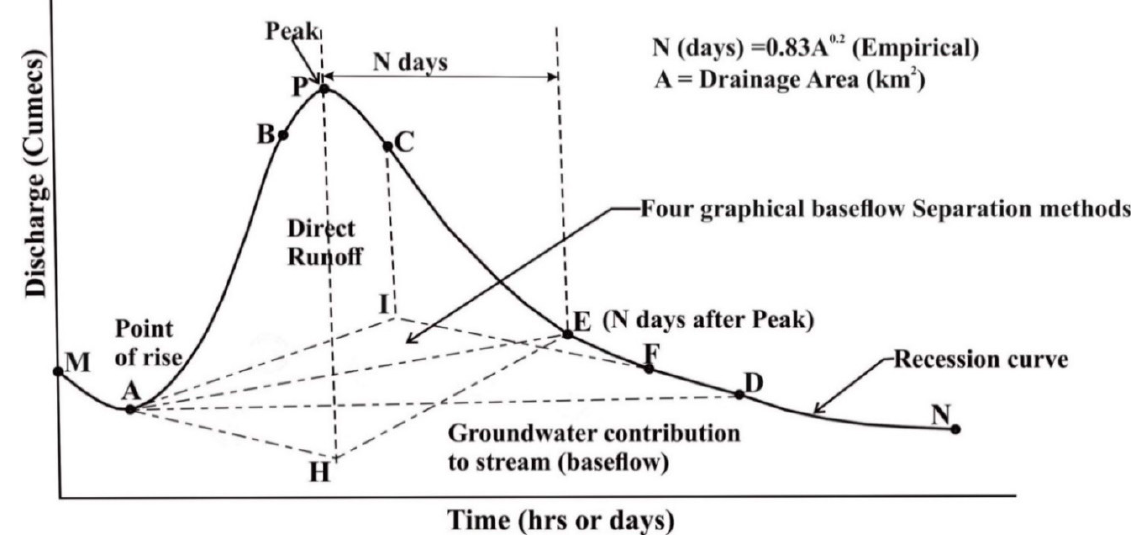
Figure 8. Graphical baseflow separation techniques modified from [49].